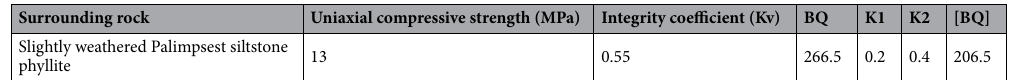
Table 2. Rock mass quality indicators BQ and correction value [BQ]. Rw rock uniaxial compressive strength (MPa) (average of the slightly weathered palimpsest siltstone and phyllite), Kv rock integrity coefficient, K1 groundwater influence coefficient, K2 weak structural plane occurrence affect the correction factor, V pm the mass elastic longitudinal wave velocity (km/s), V pr rock elastic longitudinal wave velocity (km/s). Value calculation formula is [BQ] = BQ − 100 (K1 + K2).